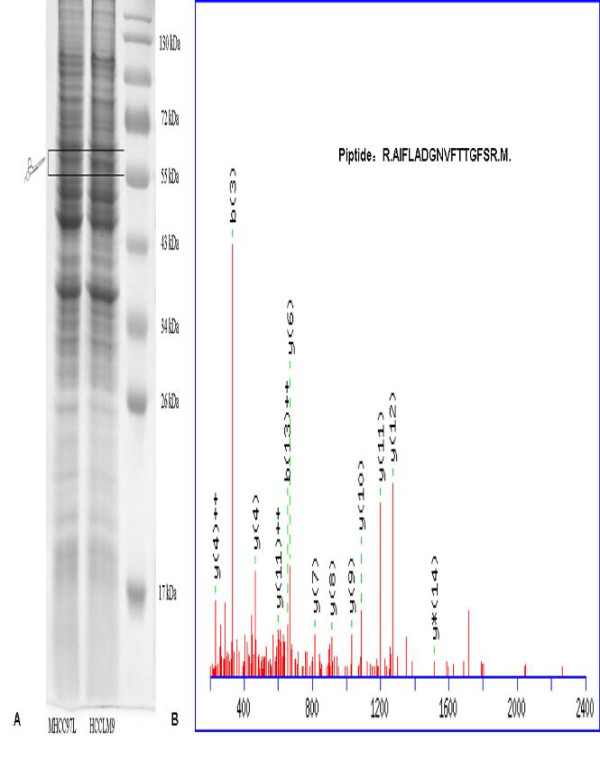
Coronin-1C was identified as differentially expressed protein between HCCLM9 and MHCC97L cells. (A) Membrane proteins were extracted from MHCC97L and HCCLM9 cells and compared by SDS-PAGE analyses. (B) The differential and interesting protein bands were excised and analyzed by ESI-MS/MS. One of MS/MS maps for Coronin-1C identification and the sequence of precursor were analyzed by MS/MS to be R.AIFLADGNVFTTGFSR.M.